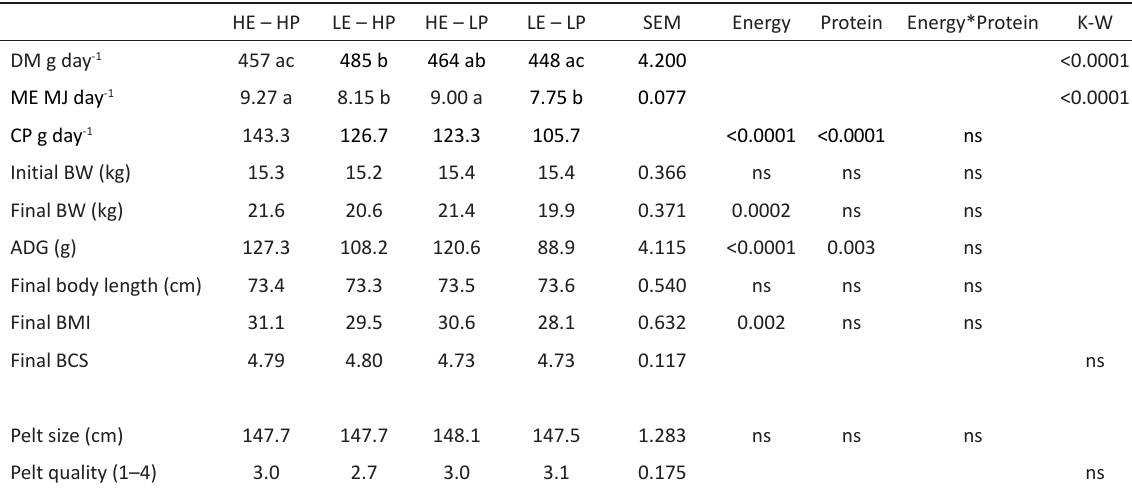
Table 3. Dry matter (DM), crude protein (CP), and metabolisable energy (ME) intake from 18 October–7 December (50